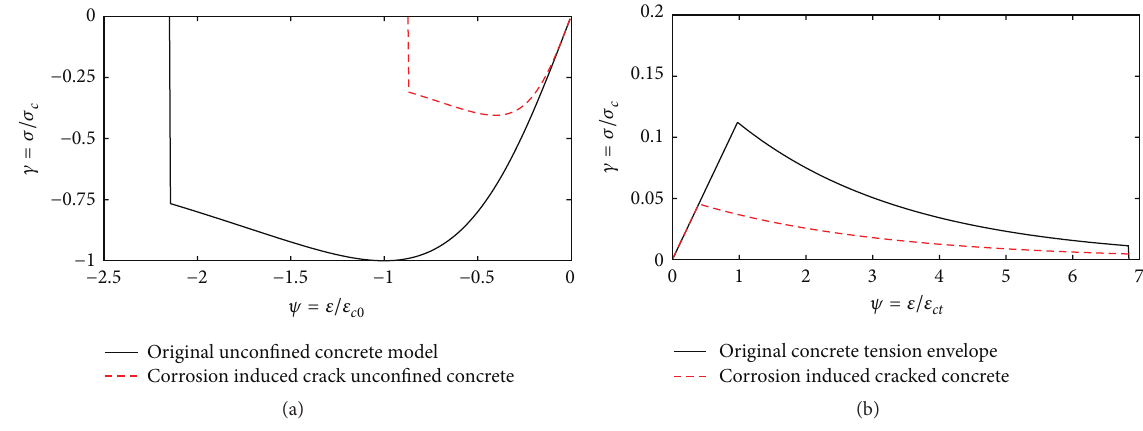
Figure 7: Corrosion damaged cracked cover concrete model for 20% mass loss: (a) compression; (b)